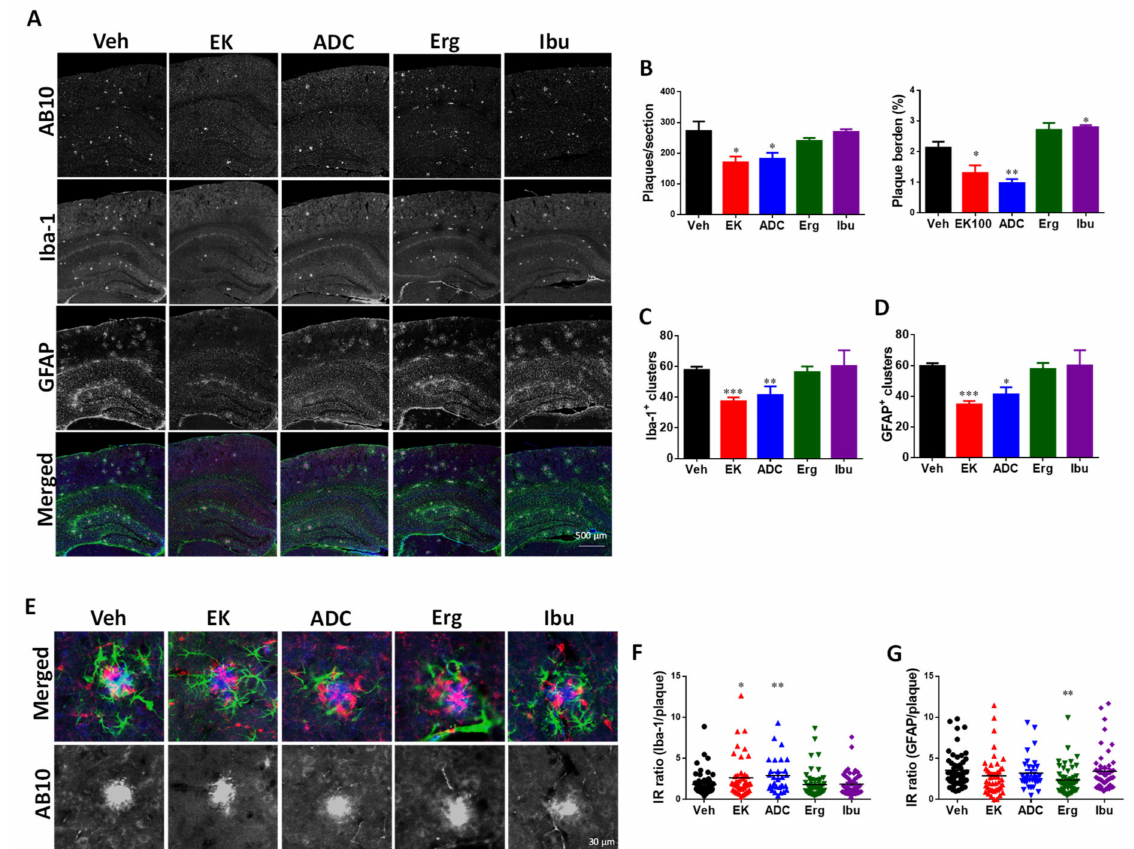
Figure 3. EK100 and antrodin C reduce amyloid plaque load, number of glial clusters, and plaque-related glial activation in APP/PS1 mice. APP/PS1 transgenic mice orally administered vehicle (Veh) or EK100 (EK), antrodin C (ADC), ergosterol (Erg), and ibuprofen (Ibu) (30 mg · kg − 1 · day − 1 , each n = 6) 1 months, and then amyloid plaques, microglia, and astrocytes were immunostained with AB10, Iba-1, and GFAP antibodies, respectively. ( A ). The representative fluorescent images of AB10 (blue in the merged panel), Iba-1 (red in the merged panel), and GFAP (green in the merged panel) are shown. Scale bar: 500 µ m. ( B – D ), The number and burden of AB10-stained plaque ( B ) and the number of Iba-1 + clusters ( C ) and GFAP + clusters ( D ) in cerebral hemisphere are counted and shown. The results are the mean ± S.E.M. Significant differences between the Veh group and reagent-treated groups are indicated by *, p < 0.05; **, p < 0.01; ***, p < 0.001. ( E ). The representative fluorescent images of glial clusters immunostained with AB10 (blue in the merged panel), Iba-1 (red in the merged panel), and GFAP (green in the merged panel) antibodies are shown. Scale bar: 30 µ m. ( F , G ). The immunointensity (IR) ratio of Iba-1 to AB10 ( F ) and GFAP to AB10 ( G ) are calculated and shown. The results are the mean ± S.E.M. Significant differences between Veh group and reagent-treated groups are indicated by *, p < 0.05; **, p <